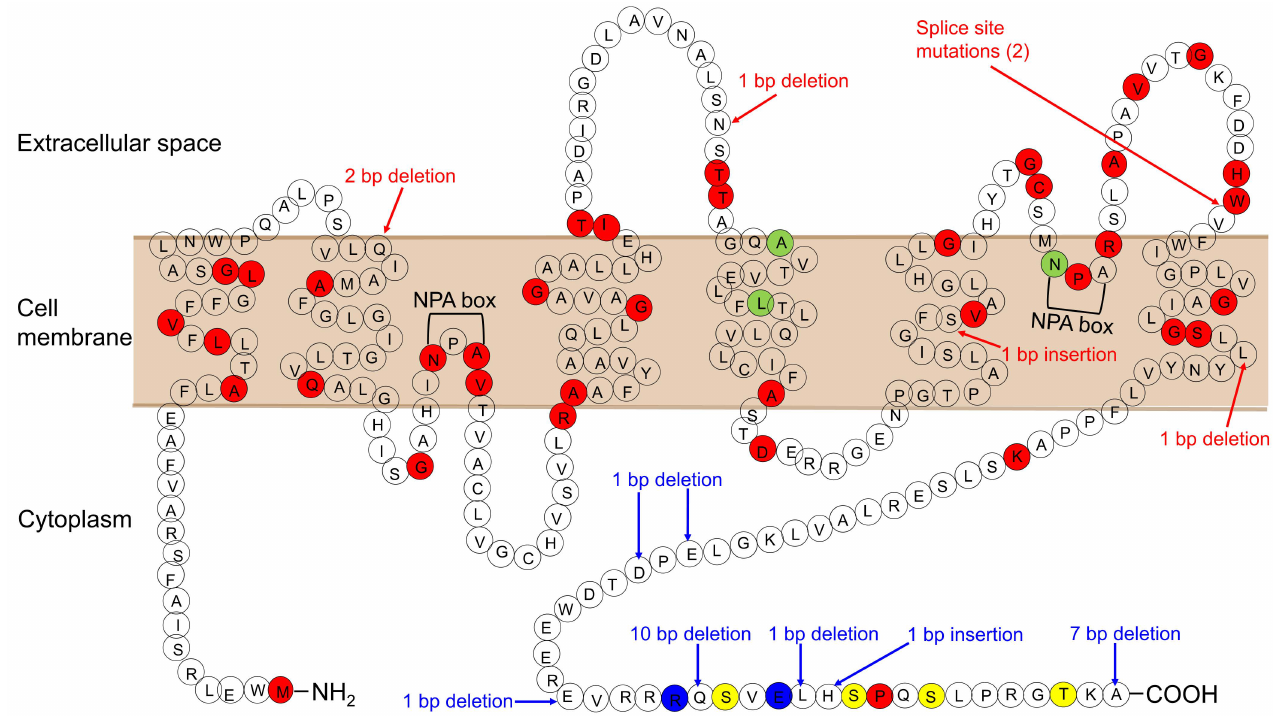
Figure 1. AQP2 mutations causing NDI. Mutations causing the autosomal-recessive form are shown in red. Mutations causing the autosomal-dominant form are shown in blue. Mutations, whose inheritance pattern is unknown, are shown in light green. Phosphorylation sites are shown in